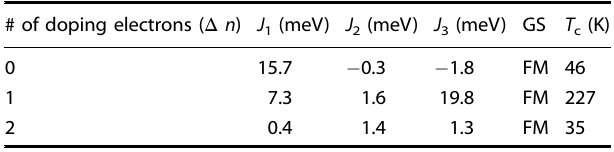
Table 2. Magnetic exchange parameters and critical temperature for each number of doping electrons in the formula unit